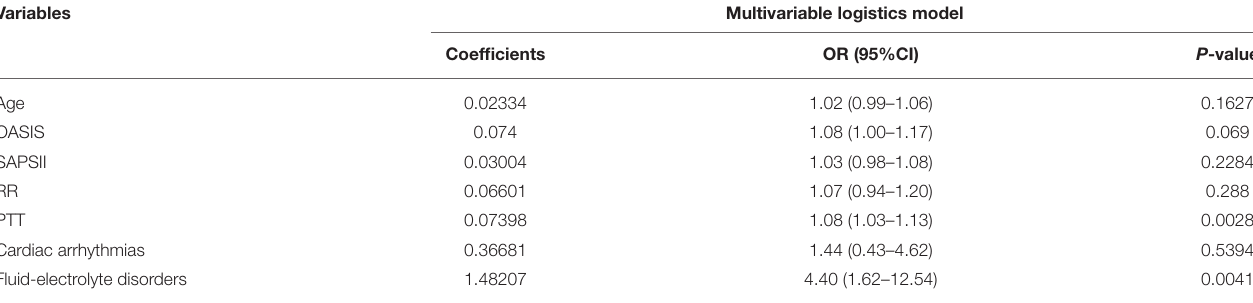
TABLE 2 | Multivariate regression model based on LASSO regression results.